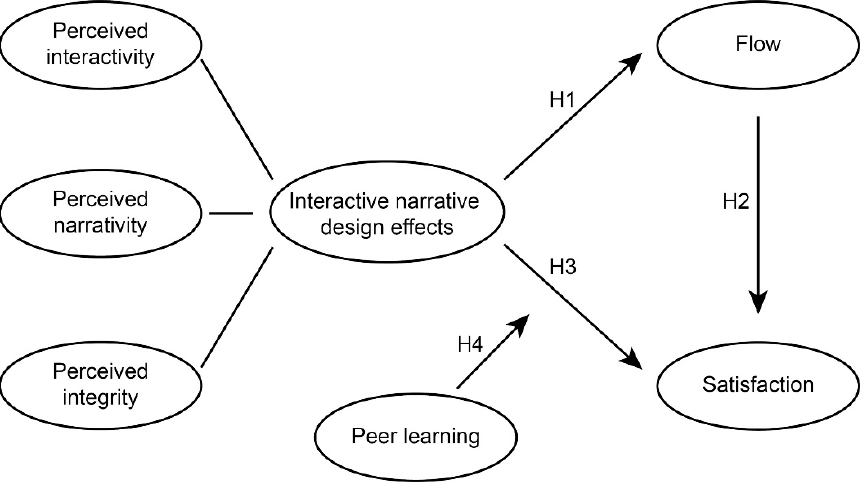
Figure 3. Research hypothesis diagram. Figure 4. Research hypothesis